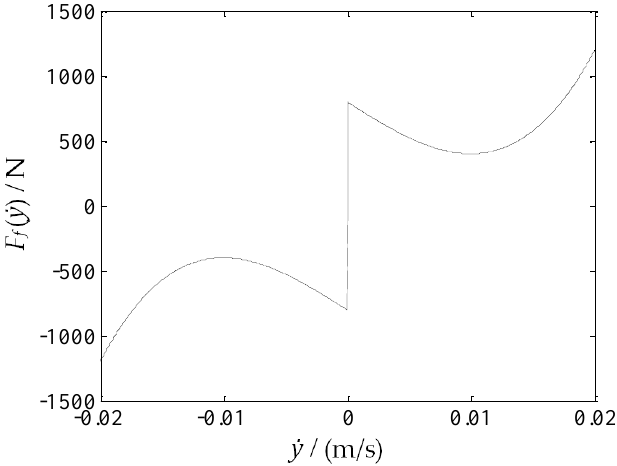
Figure 5. Piecewise nonlinear friction force of hot rolling mill rolls in the vertical direction.